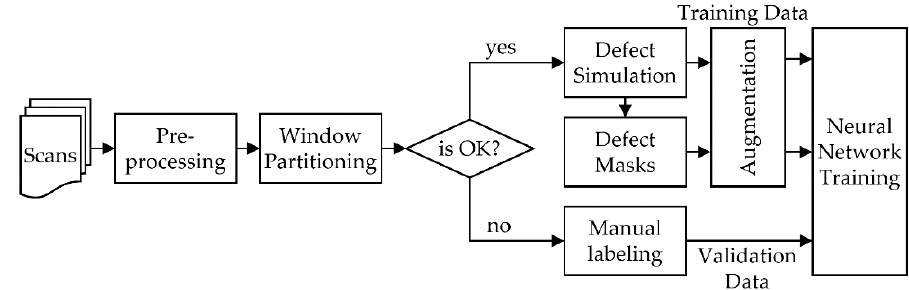
Figure 6. A flowchart of the data collection and training process. A dataset of simulated defects is generated for training. Defect samples in the scanned parts are labeled and used as validation data.